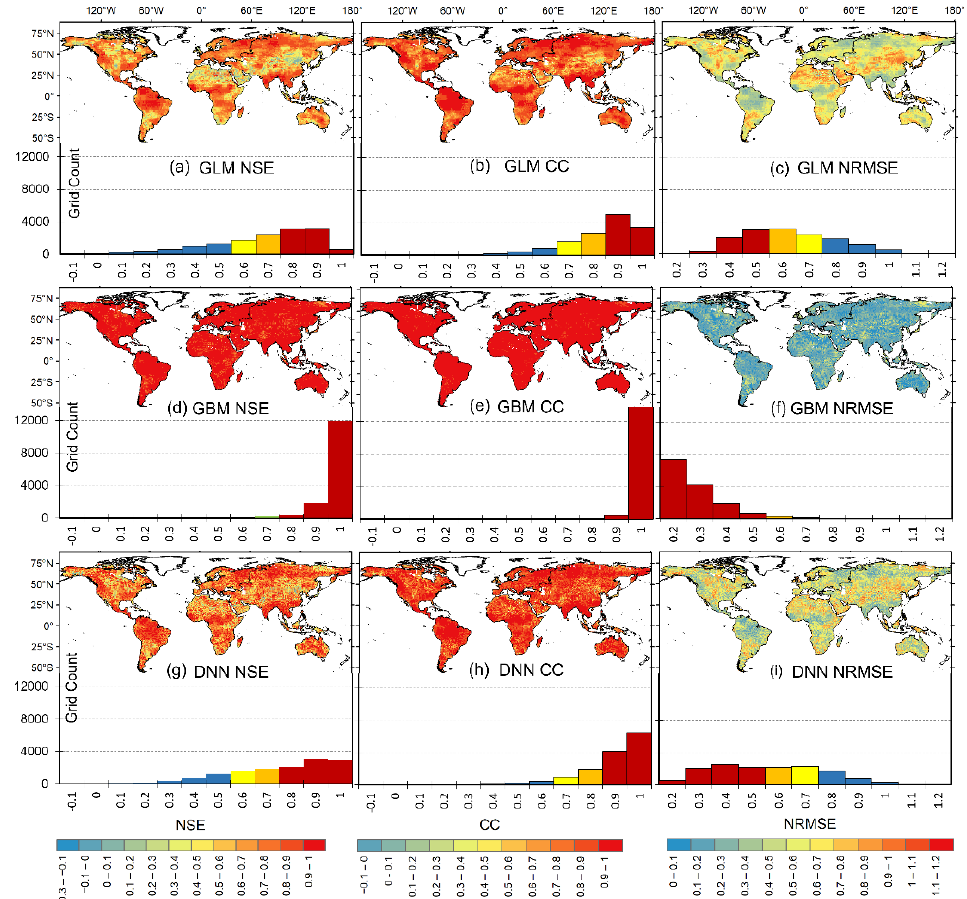
Figure A1. Spatial (maps) and frequency (bar plots) distributions of the grid-scale training perfor- mance for the ( a – c ) GLMs, ( d – f ) GBM models, and ( g – i ) DNN models. The color-coded frequency distribution shows the very good (red), good (orange), satisfactory (yellow), and poor (blue) perfor- mance categories.